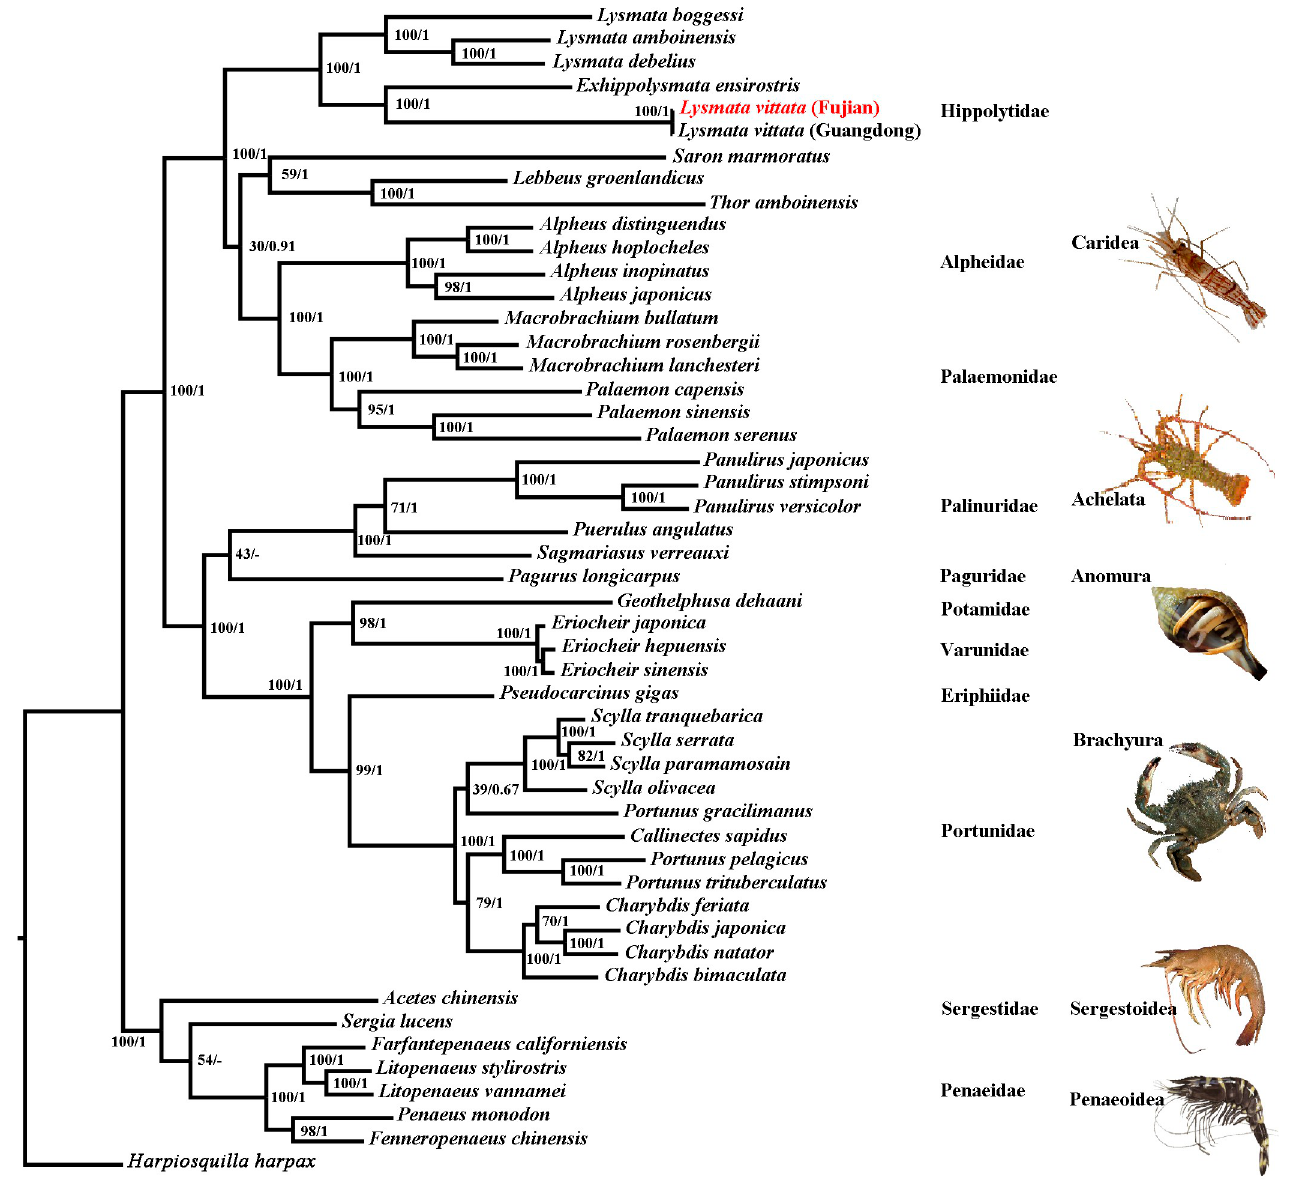
Fig 4. Phylogenetic tree inferred from nucleotide sequences of 13 PCGs of the mitogenome using ML and BI methods (BP/PP).